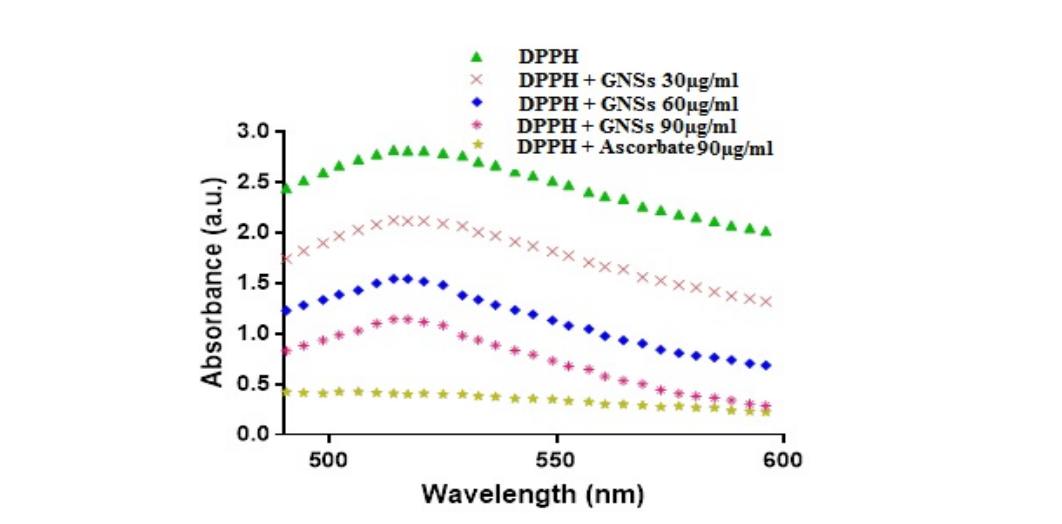
Figure 8. DPPH scavenging assay at various experimental doses of REEW-GNs and ascorbic acid (standard) as measured by acquiring absorption spectra in the 500–600 nm range. Table 2. DPPH radical scavenging potential of REEW-GNs in comparison with ascorbic acid at different reaction times.